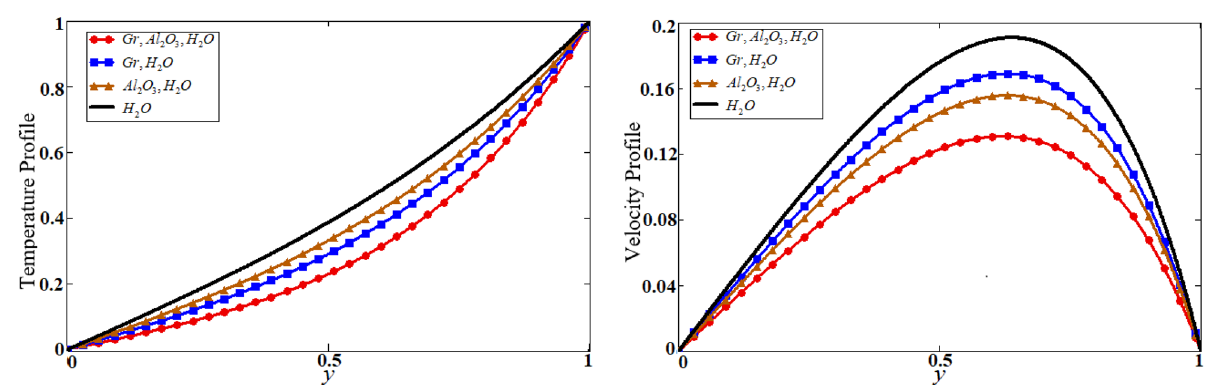
Figure 6. Comparison of hybrid nanofluid with nanofluid on temperature and velocity